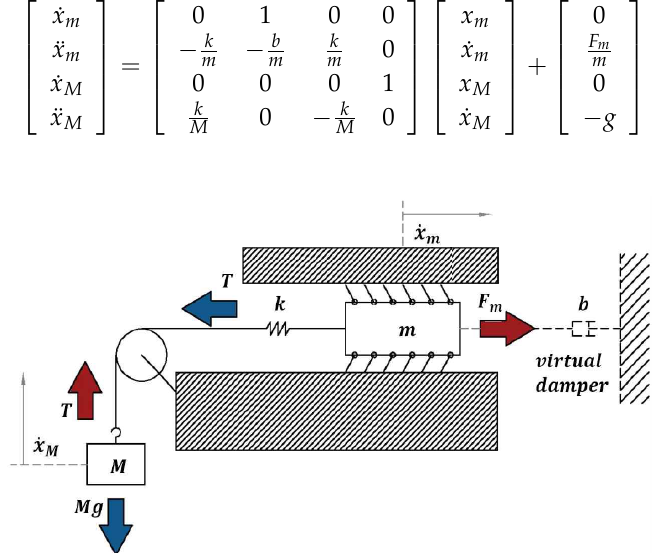
Figure 4. The free body diagram to derive an interactive control model between the HSAM and the wire-attached mass pulled downward by